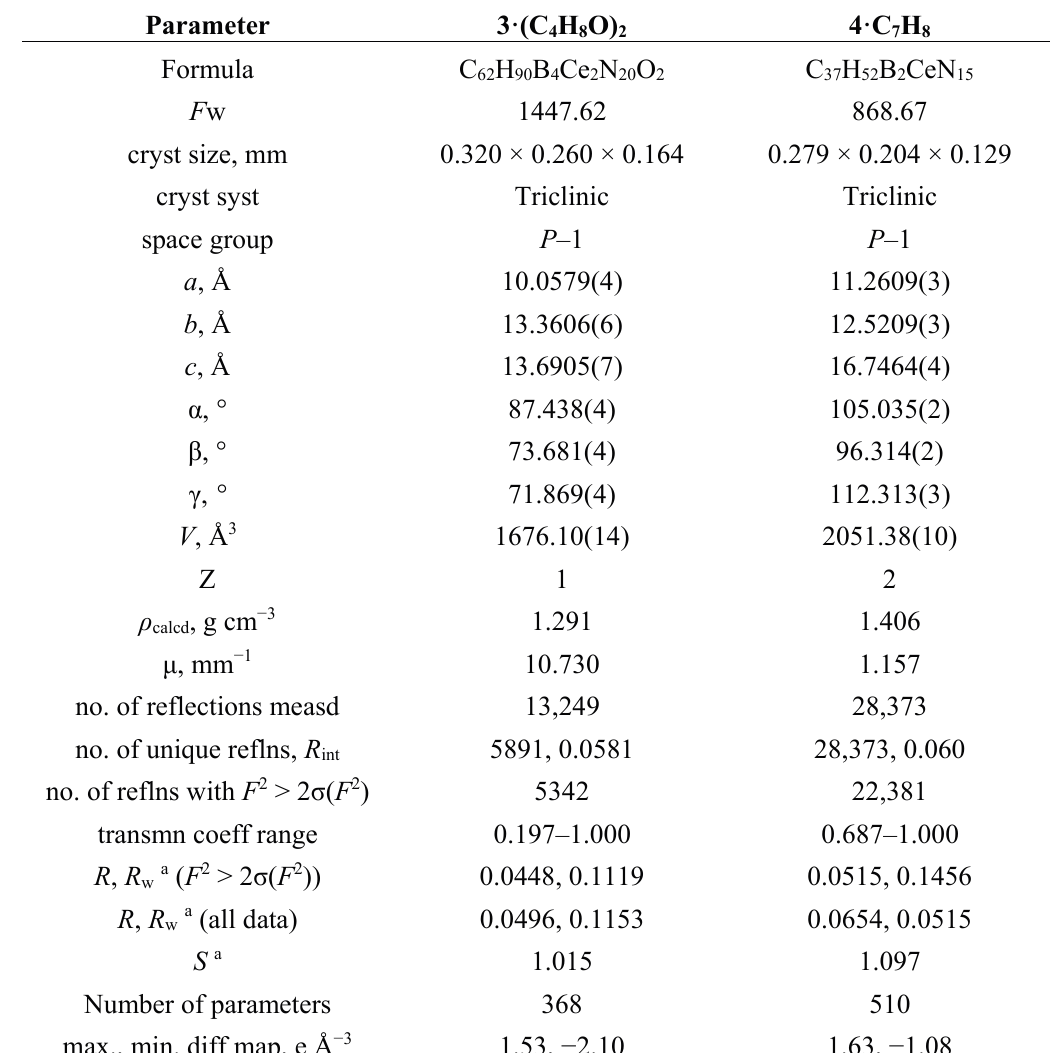
Table 3. Crystallographic data for 3 – 4